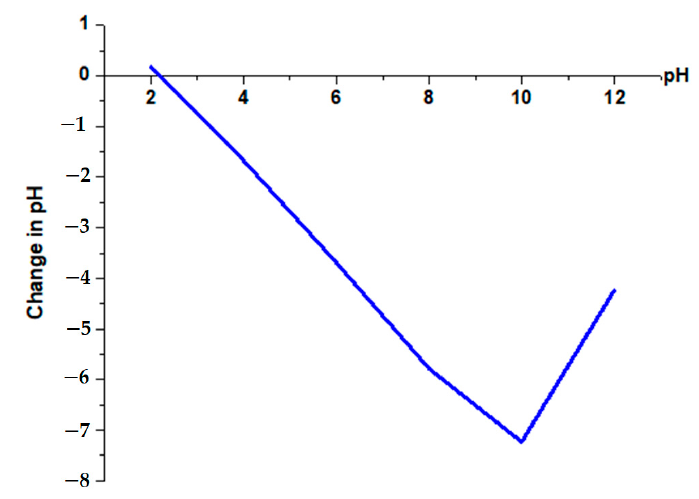
Figure 10. The pHpzc value of